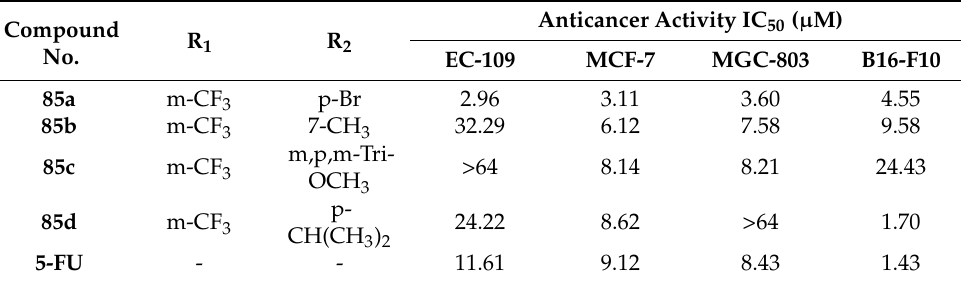
Figure 82. Structure of triazole-pyrimidine derivatives ( 85 Figure 81. Structure of curcumin ‐ isatin derivatives ( 84 ).